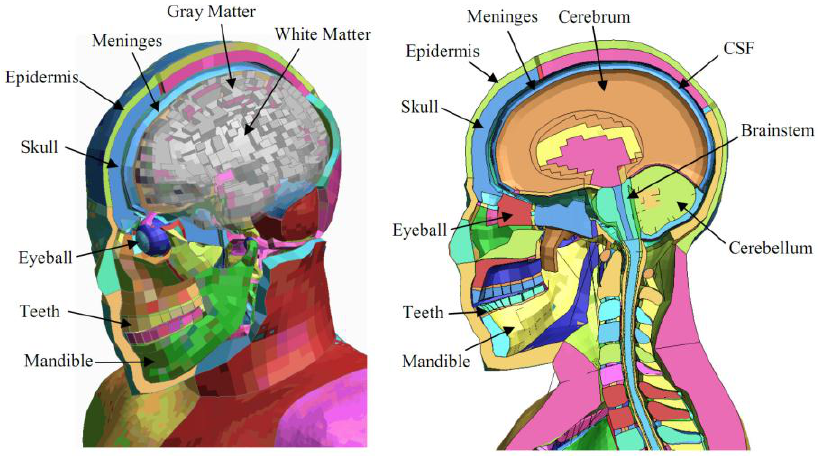
Figure 2. Head finite element model [40,42].